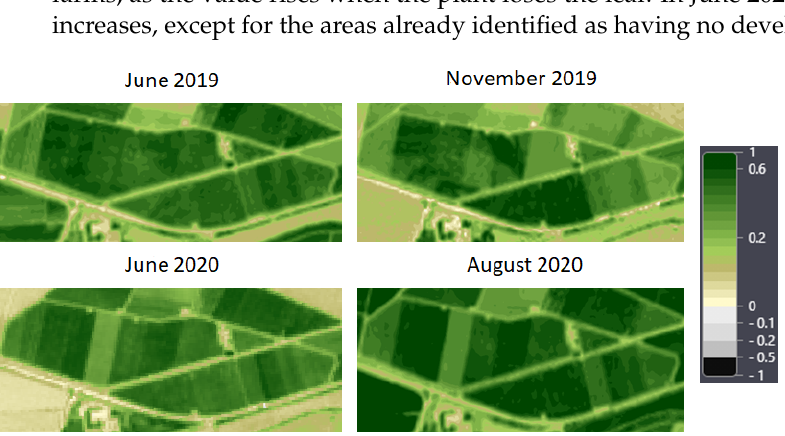
Figure 11. Evolution of the NDVI index in stone fruit tree exploitation.